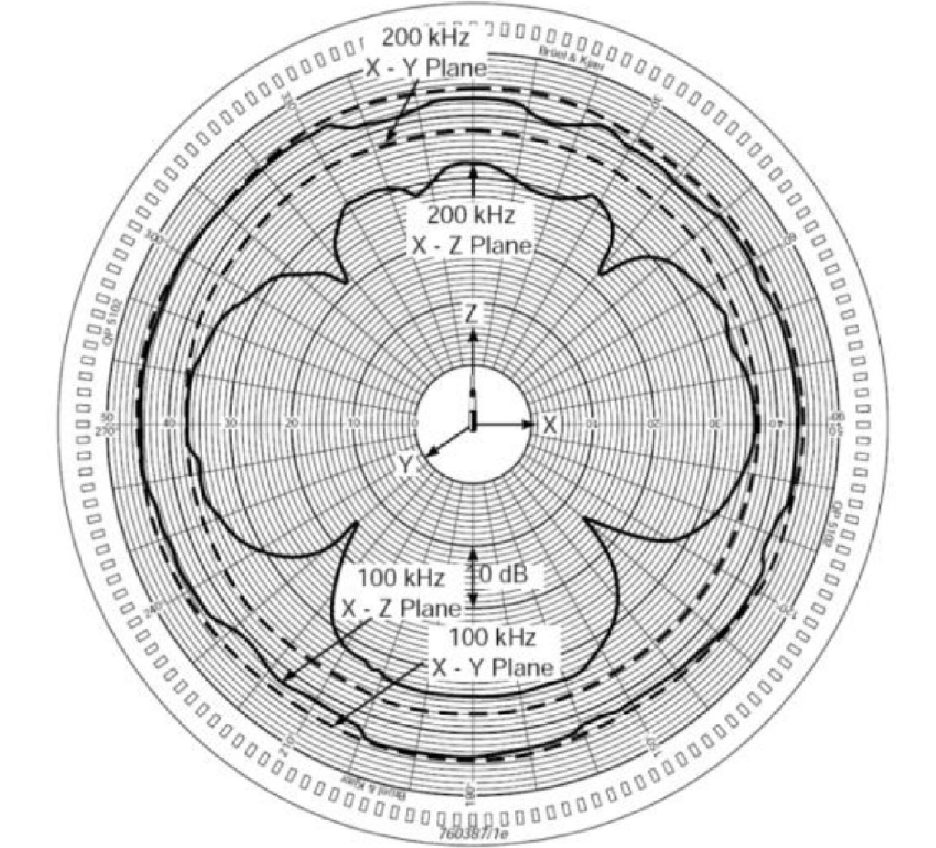
Figure 6. Bruel & Kjær Hydrophone Type 8103 directivity pattern.